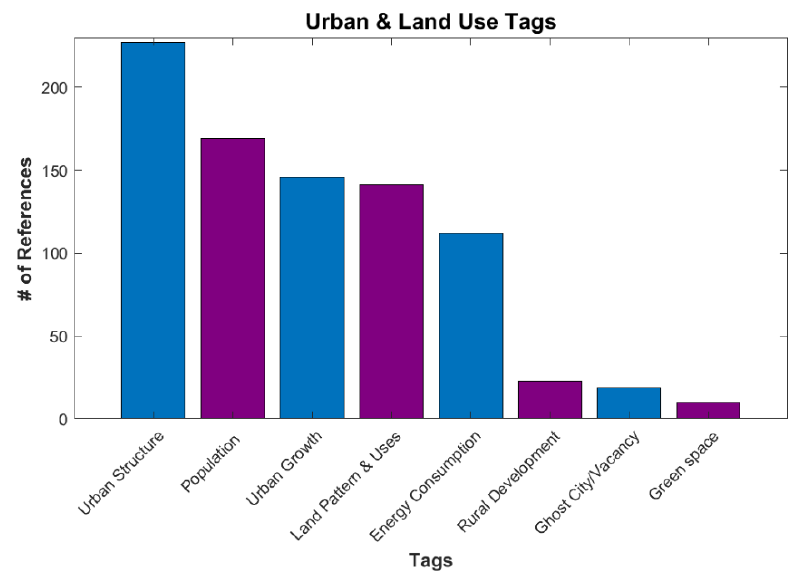
Figure 6. Number of references for various tags under Applications/Urban and Land Use.